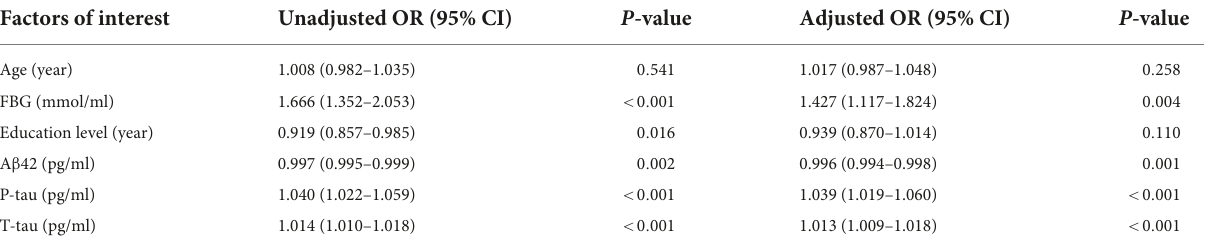
TABLE 2 Logistic regression